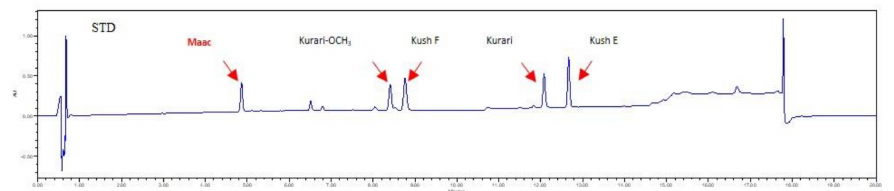
Figure3. Chromatogram(totalruntime = 20min)ofauthenticstandardsofMaac(4.9min), Kurari-OCH3 (8.4 min), Kush F (8.78 min), Kurari (12.1 min), and Kush E (12.65 min). Maac, maackiain; Kurari-OCH3, methoxy kurarinone; Kush F, kushenol F; Kurari, kurarinone; Kush E, Kushenol E.